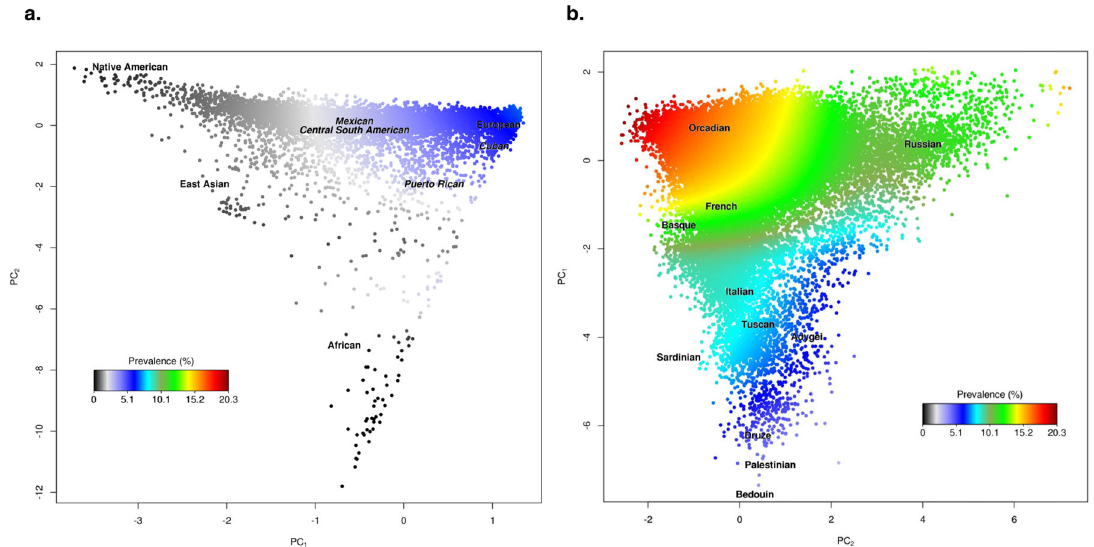
Fig. 1 Ancestry contour fi gure showing cSCC prevalence by genetic ancestry in GERA. a Hispanic/Latinos ( N = 8490 individuals, including 294 cSCC cases); b non-Hispanic whites ( N = 78,583 individuals, including 11,028 cSCC cases). cSCC prevalence is indicated on a color scale, with red hues indicating higher prevalence. Axes re fl ect the fi rst two principal components of ancestry. Nationality subgroup labels were derived from the Human Genome Diversity Project. Table 2 Associations between genetic ancestry and cSCC risk in GERA non-Hispanic whites and Hispanic/Latinos. Non-Hispanic whites Hispanic/Latinos β (SE) P value β (SE) P value Model 1: Ancestry (age, sex, and PCs as covariates) PC1 Model 2: Model 1 and HIrisPlex-S skin pigmentation predictions PC1